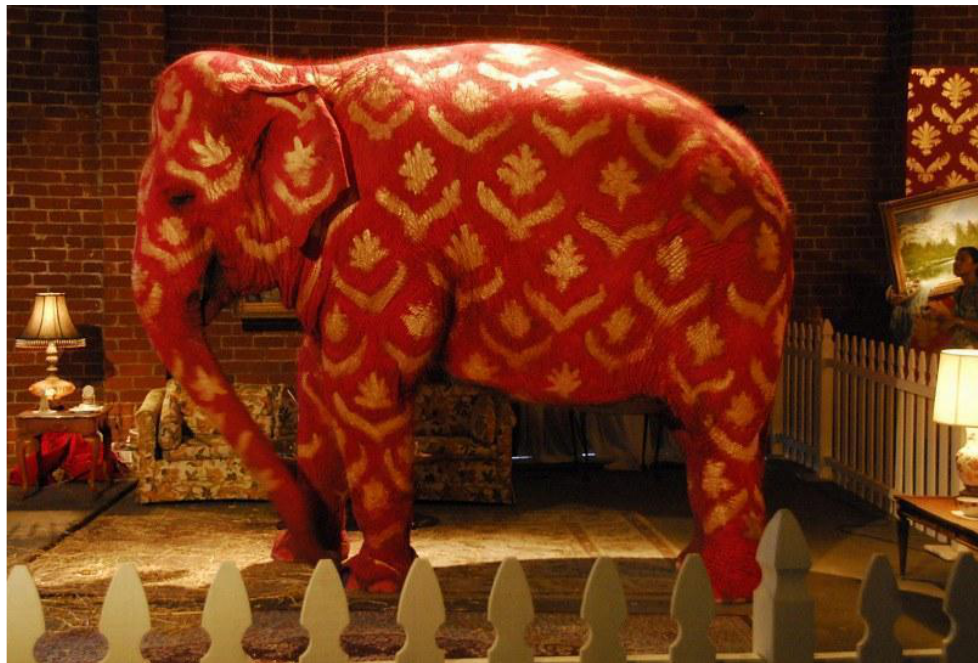
Figure 2. Photo by Bit Boy (2016). Source: